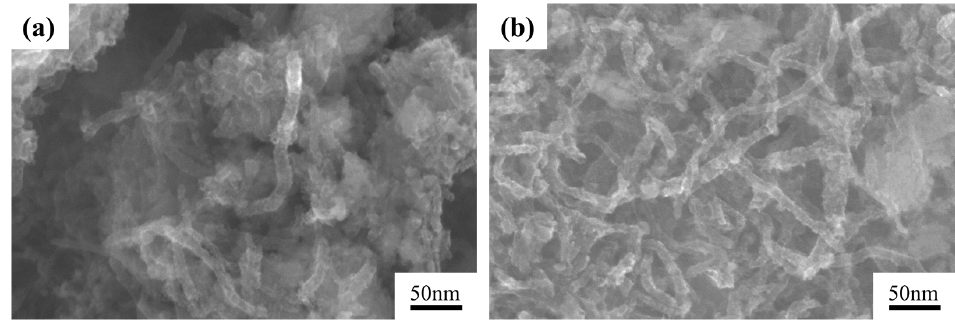
Figure 4. SEM image of surface morphology of Ni-CNTs ( a ) before and ( b ) after pre-dispersion.